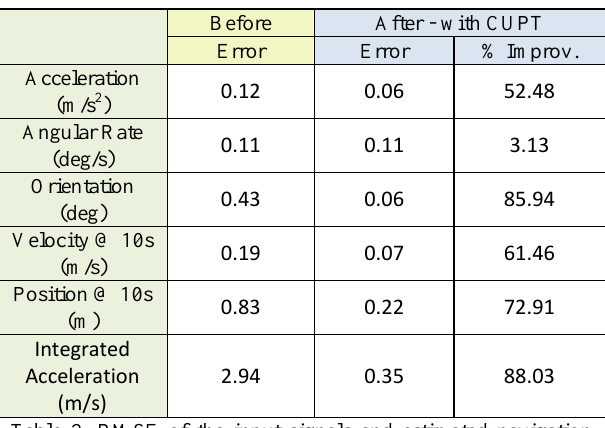
Table 2: RMSE of the input signals and estimated